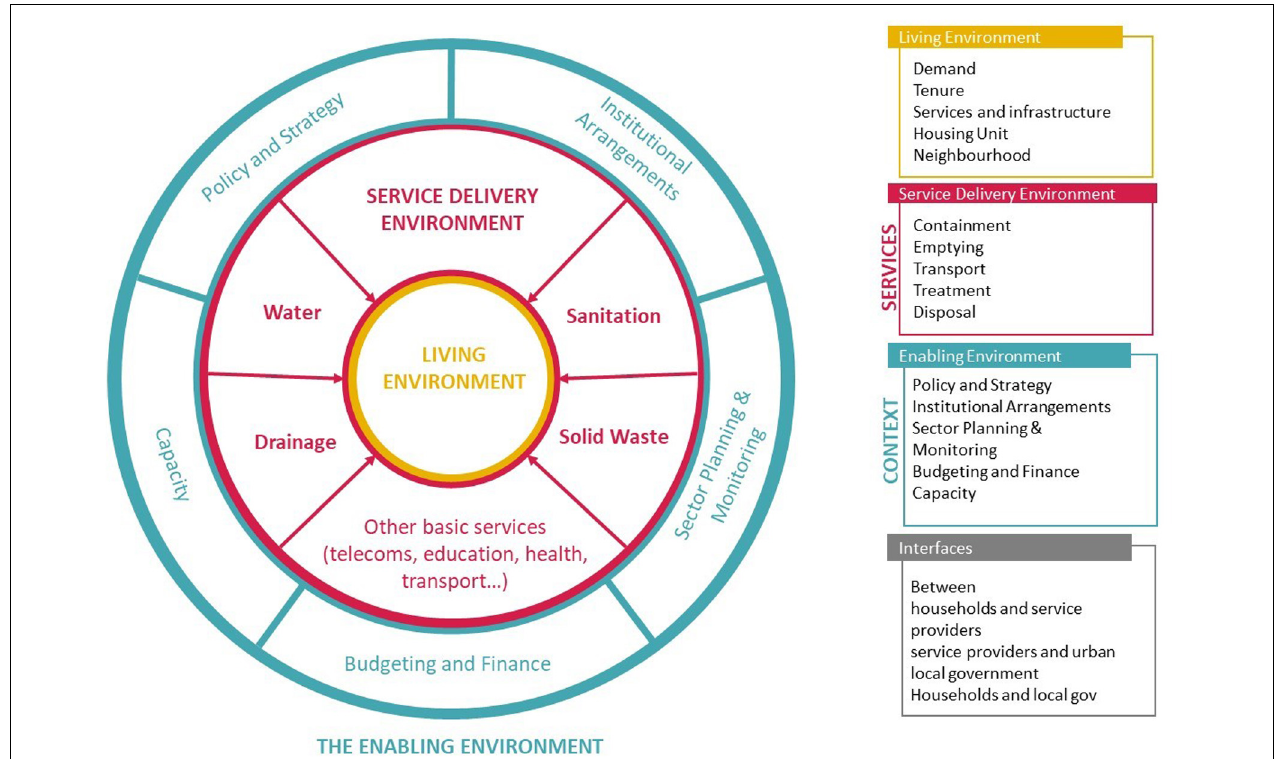
FIGURE 1 | The Sanitation Cityscape conceptual